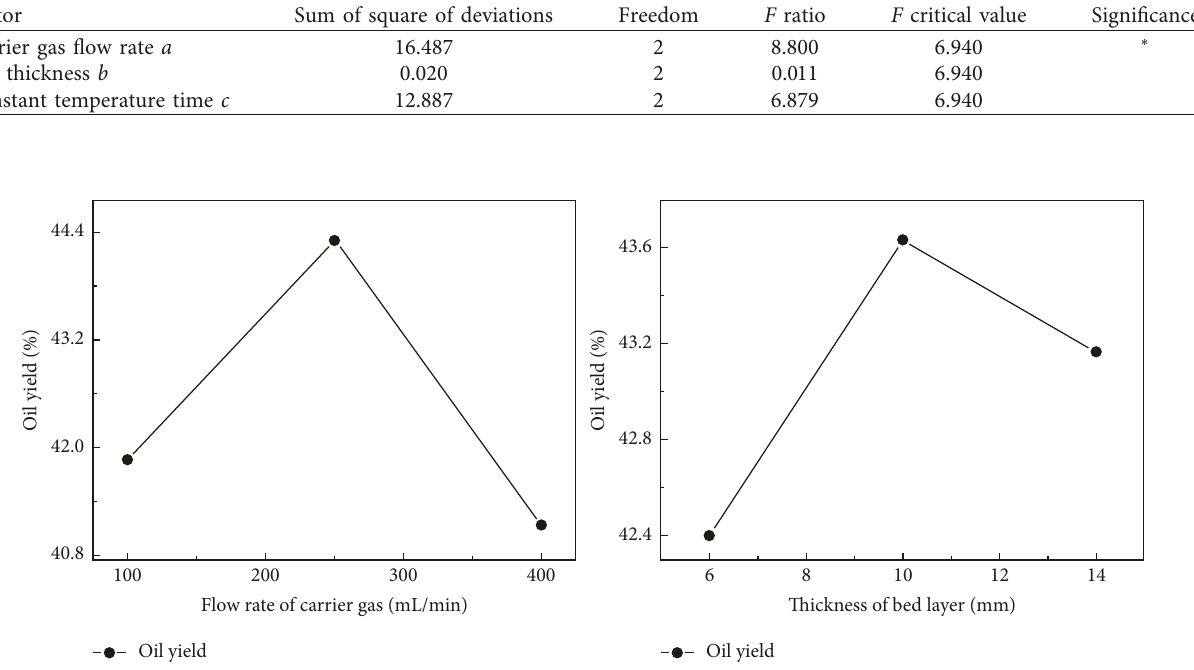
934 ) effect curves of various factors.